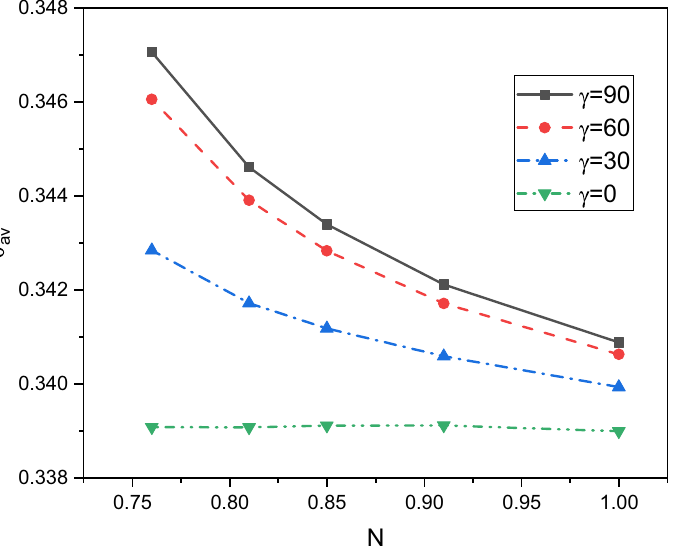
Figure 10. Impacts of the power-law index N and inclination angle γ on the bulk-averaged temperature at Ra = 10 5 , Da = 10 − 3 , b = 0.6, d = 0.5, Ma = 1000, β = 0.95, τ = 1, φ = 2%, Rd = 1, � = 10 − 4